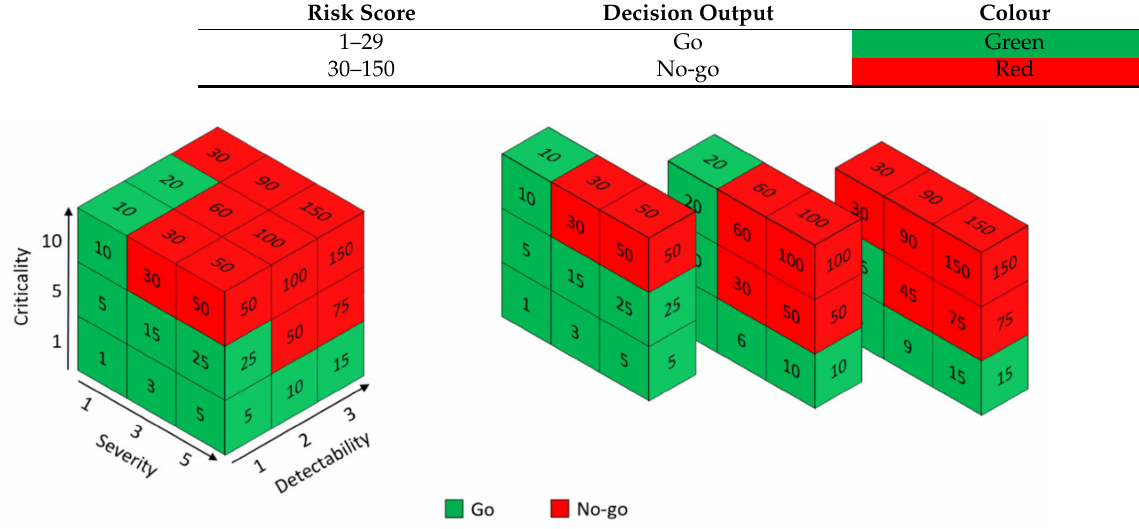
Figure 10. Three-dimensional go/no-go